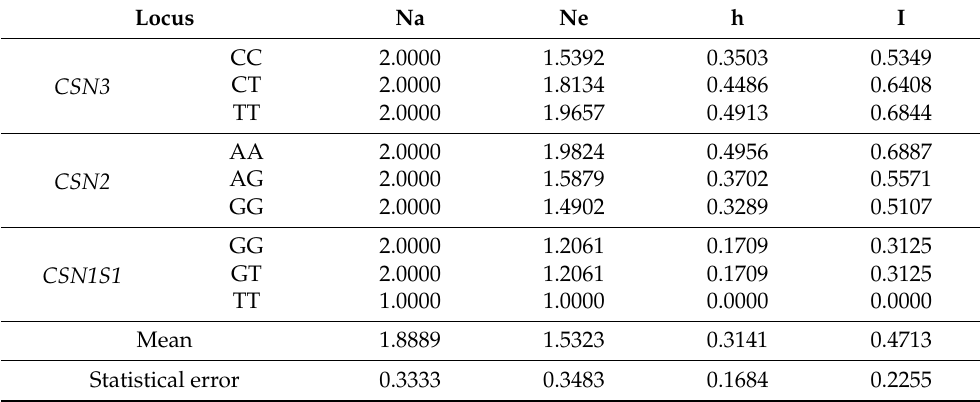
Table 4. Summary of the genetic variation statistics for all